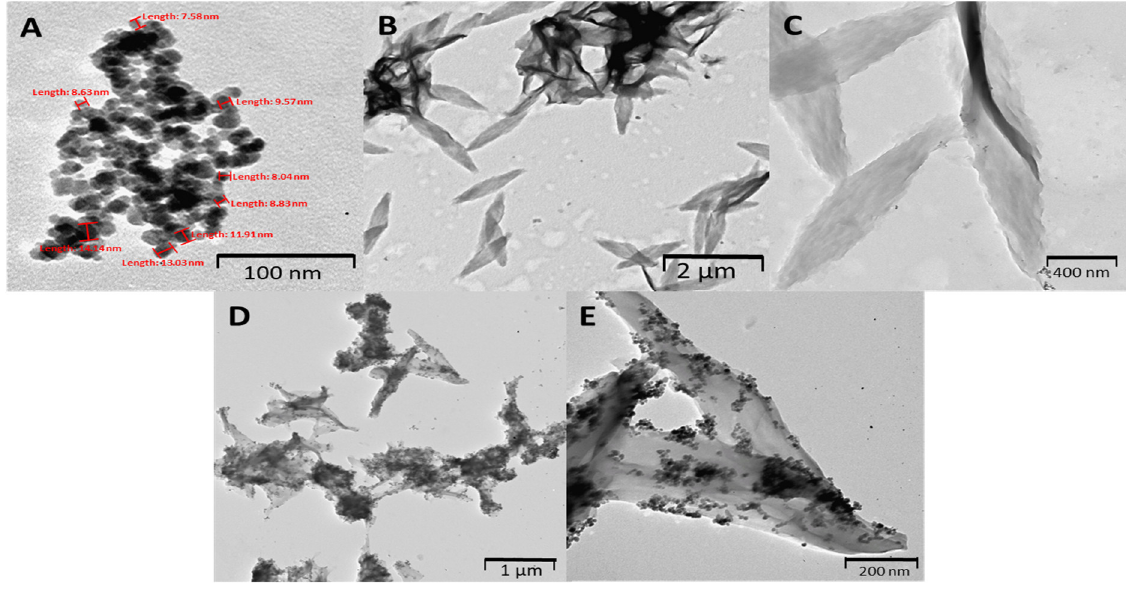
Figure 1. TEM images of magnetic nanoparticles (MNPs). ( A ) High-magnification TEM image initial Fe 3 O4 MNPs, the bar indicates 100 nm. ( B ) Low-magnification TEM image MNP1%@Ny6, the bar indicates 2 μm. ( C ) High-magnification TEM image MNP1%@Ny6, the bar indicates 400 nm. ( D ) Low-magnification TEM image MNP5%@Ny6, the bar indicates 1 μm. ( E ) High-magnification TEM image MNP5%@Ny6, the bar indicates 200 nm.